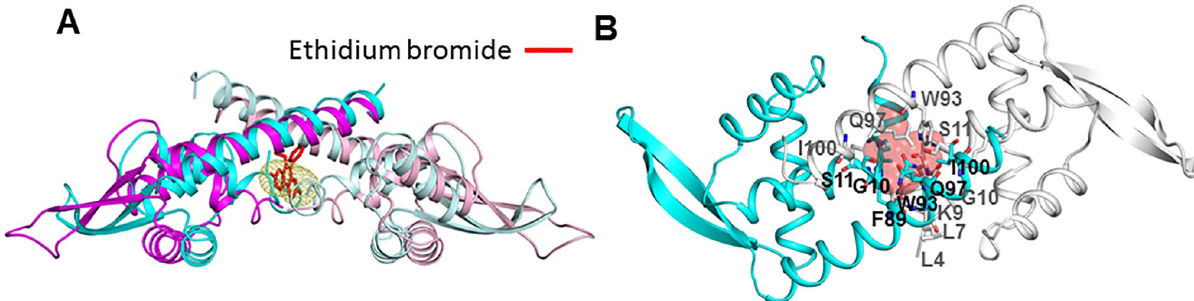
Fig 6. Intersubunit cavity of LftR as a putative ligand-binding site. (A) LftR dimers (the LftR Δ NtH structure, cyan and gray ribbons; the LftR CtH structure, magenta and light magenta ribbons) shown with an ethidium bromide molecule (red sticks), which was identified as an artificial ligand of LftR. (B) Steric clashes of LftR residues with ethidium bromide. Ethidium bromide is shown as red transparent spheres, and the LftR Δ NtH structure is displayed in cyan and gray ribbons. LftR residues involved in steric clashes with the ethidium bromide molecule are shown as sticks with labels.